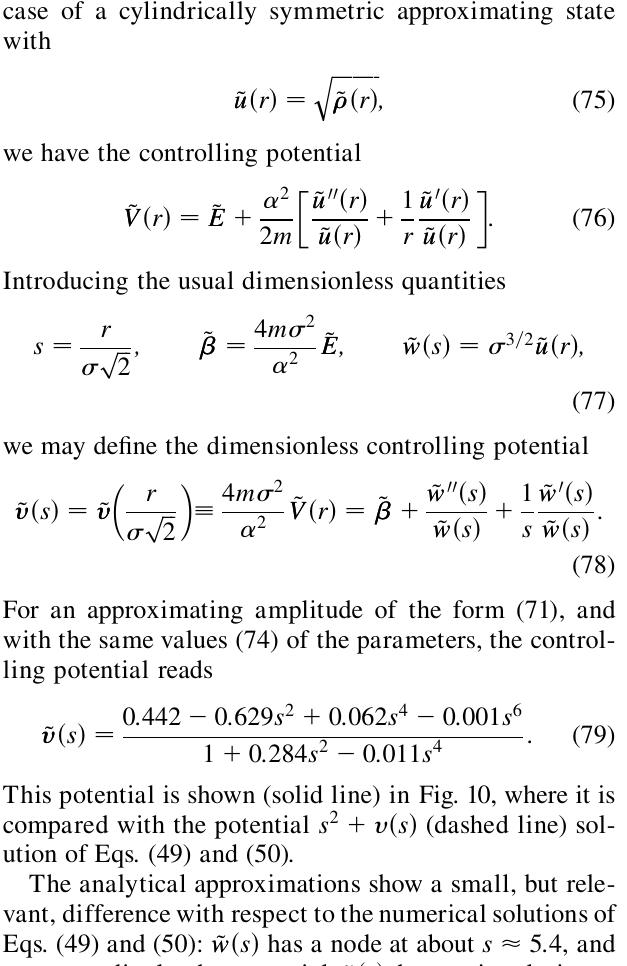
FIG. 10. The control potential (solid line) obtained from the best mean square approximation ~ ww (cid:2) s (cid:3) to a numerical solution for the self-consistent equations (49) and (50), for trial func- tions of the form (71) with (cid:7) (cid:4) 19 : 3 . It is compared with the potential s 2 (cid:5) v (cid:2) s (cid:3) (dashed line) obtained as a numerical solution of (49) and (50).